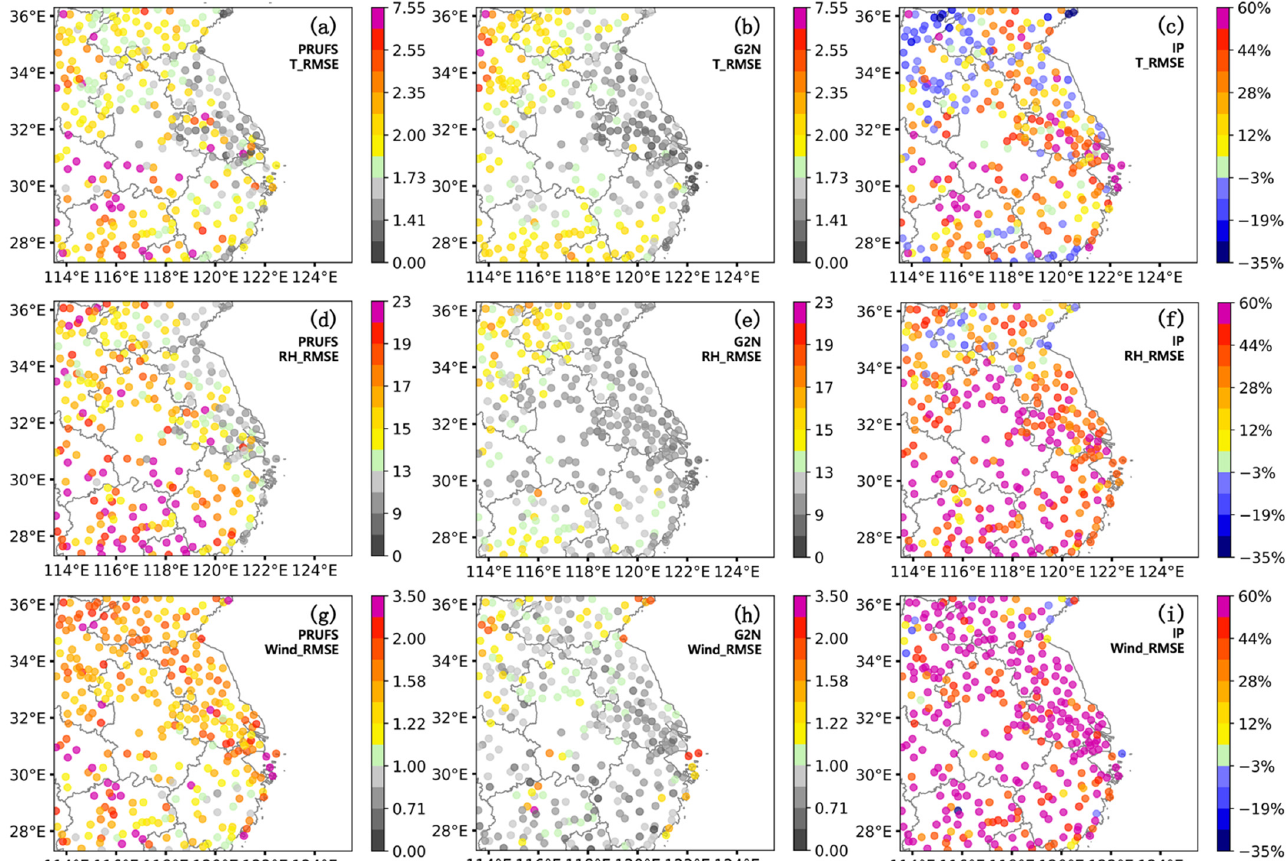
Figure 7. The RMSE of the PRUFS forecasts ( left panels ) and the G2N correction ( middle panels ) and the corresponding G2N improvement percentages ( right panels , %) of 2 m temperature ( a – c ), 2 m relative humidity ( d – f ), and 10 m wind speed ( g – i ). 2 m relative humidity ( d – f ), and 10 m wind speed ( g – i